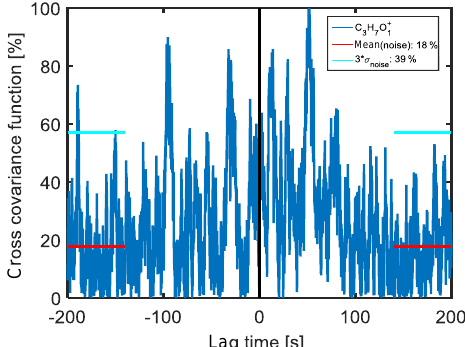
, which fulfilled the 5